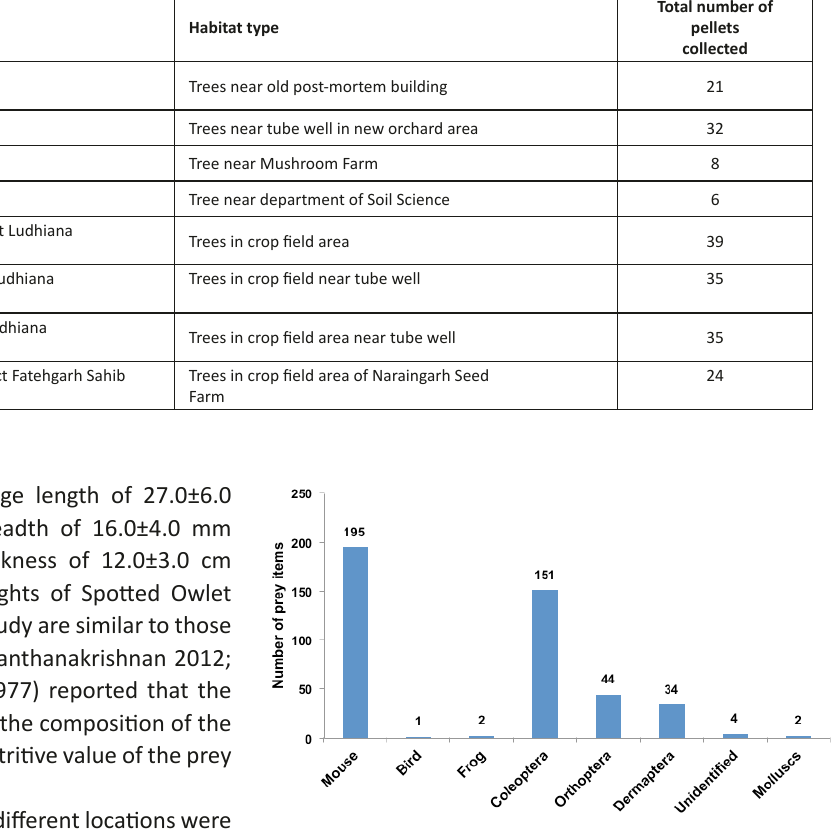
Figure 2. Total number of prey items found in pellets of Spotted Owlet at all the eight locations.